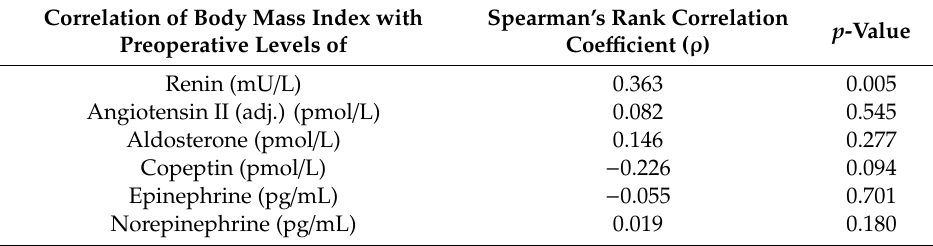
Table 4. Correlation of body mass index with different preoperative hormone levels.